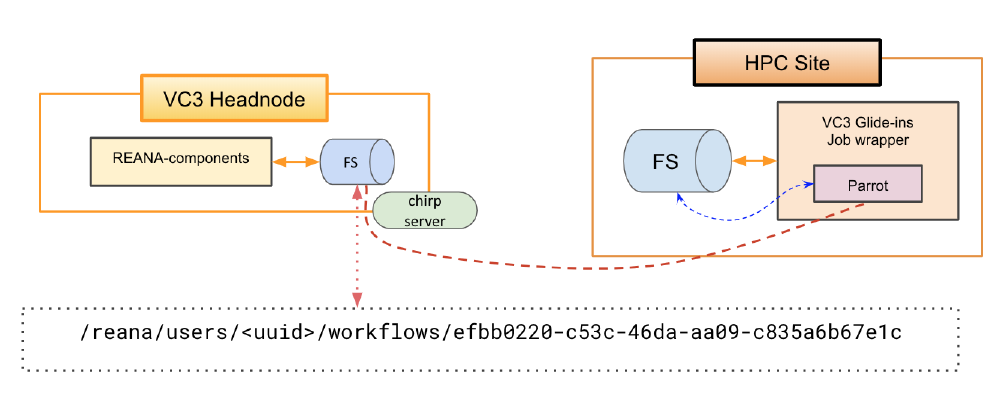
Figure 6. File management via Chirp and Parrot